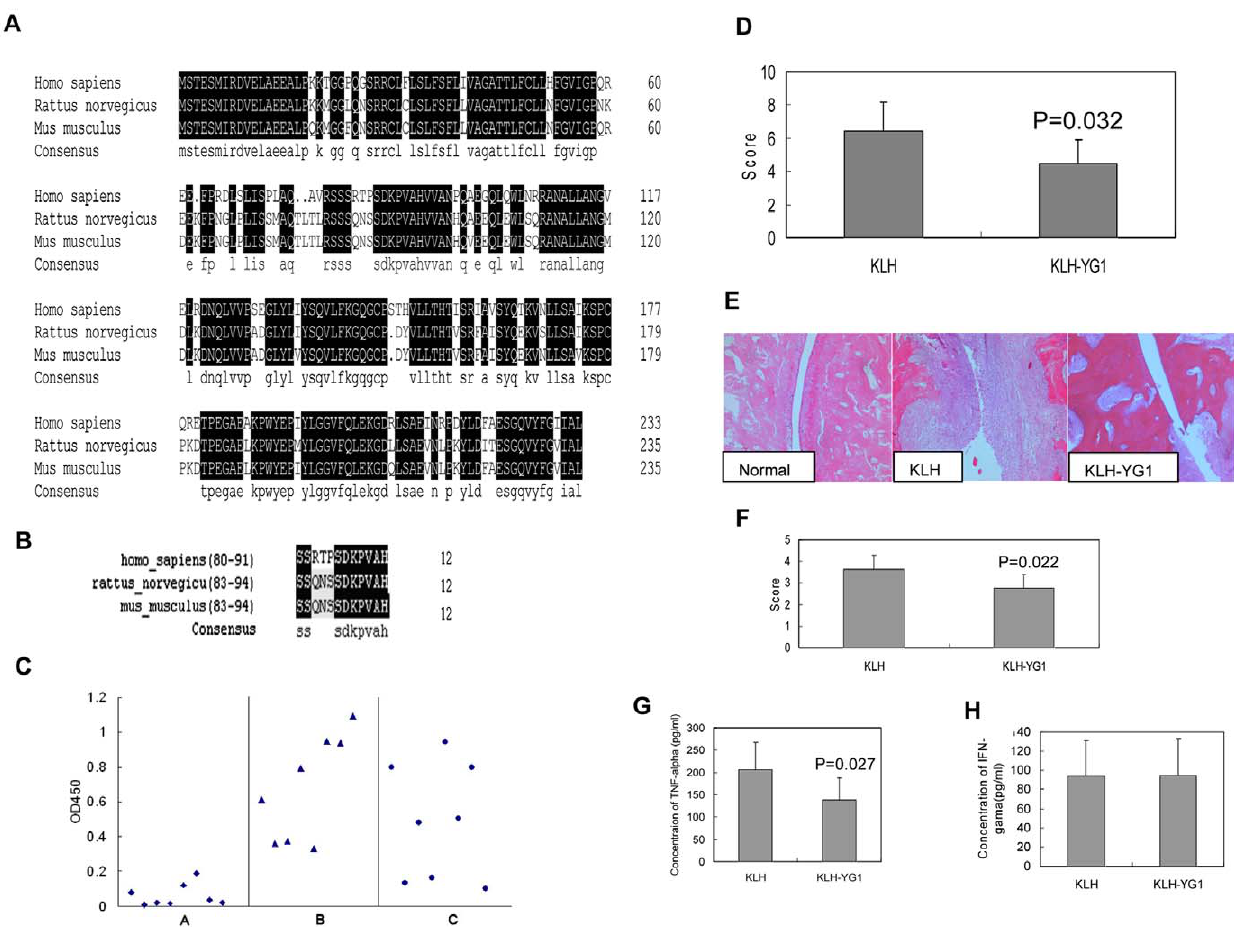
Figure 4. YG1 could suppress the development of collagen-induced arthritis in the Rheumatoid arthritis animal model. A: The homology analysis of TNF- a in human, mice and rats. B: The homology analysis of the region of TNF- a according to YG1 in human, mice and rats. C: The detection of antisera against rhTNF- a in rats. Rats in Group A were prevaccinated with KLH, while Rats in Group B and C were prevaccinated with KLH-YG1. The sera were diluted as 1:100, and the interaction between rhTNF- a and sera was tested by ELISA. D: Arthritis score. KLH represents the rats of Group A immunizied with CII, and KLH-YG1 represents the rats of Group B immunizied with CII. E: Histologic analysis of ankle joints in CIA rats. Normal represents the normal rats, KLH represents the rats Group A immunizied with CII, and KLH-YG1 represents Group B immunizied with CII (Original magnification 6 10). F: Histologic score of ankle joints in CIA rats. KLH represents the rats Group A immunizied with CII, and KLH-YG1 represents Group B immunizied with CII. G, H: Detection the concentration of different cytokines in blood. The production of TNF- a and IFN- c was analyzed in the different groups.